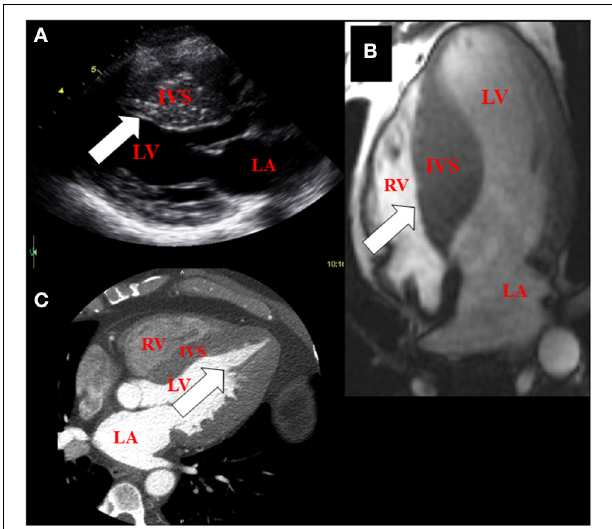
FIGURE 1 | Imaging features of hypertrophic cardiomyopathy using multi-modality cardiac imaging in patients. (A) Basal hypertrophy of the inter-ventricular septum (arrow) using echocardiography (parasternal long axis view of the heart). (B) Mid-septal hypertrophy (arrow) using magnetic resonance imaging (4-chamber view of the heart). (C) Apical hypertrophy (arrow) using Computed tomography (4-chamber view of the heart). LA, left atrium; IVS, inter-ventricular septum; LV, left ventricle; RV, right ventricle.